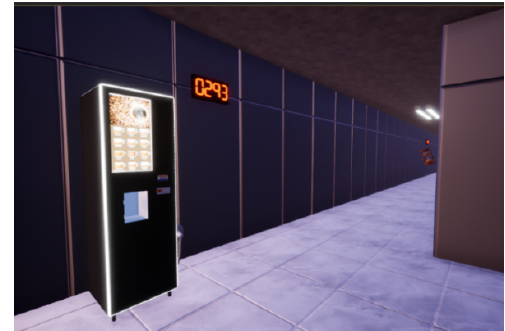
Figure 8. Example of seven-segments solution.